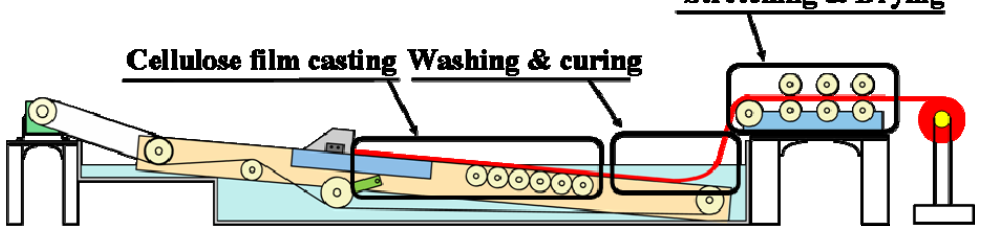
Figure 11. Configuration of mass production system of